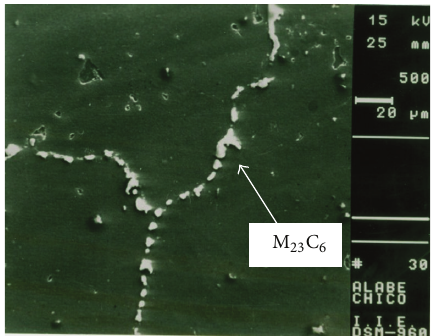
Figure 2: M 23 C 6 carbides precipitated in grain boundaries, IN738LC superalloy, after 24000 h of